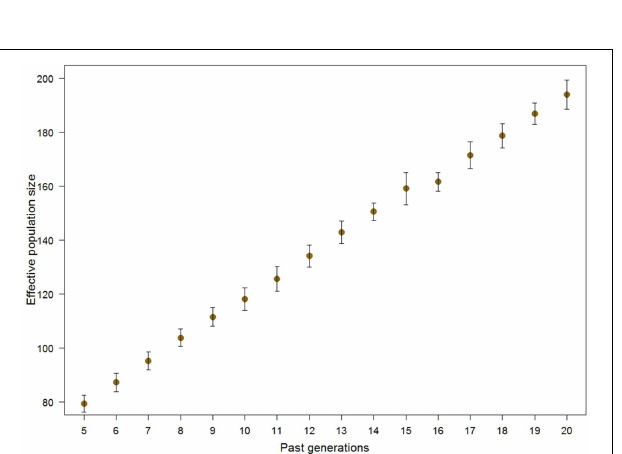
FIGURE 3 | Means and standard deviations for the historical Ne LD in Tyrol Grey cattle, accounting for mutation and ratio of genetic per physical distance of 1.25.